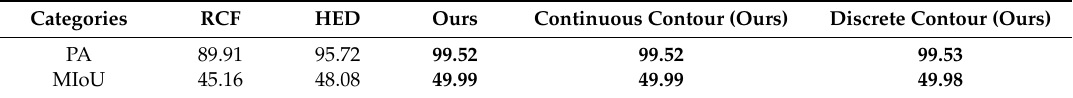
Table 2. Pixel Accuracy (PA) and Mean Intersection over Union (MIoU) by three methods (Unit: %).